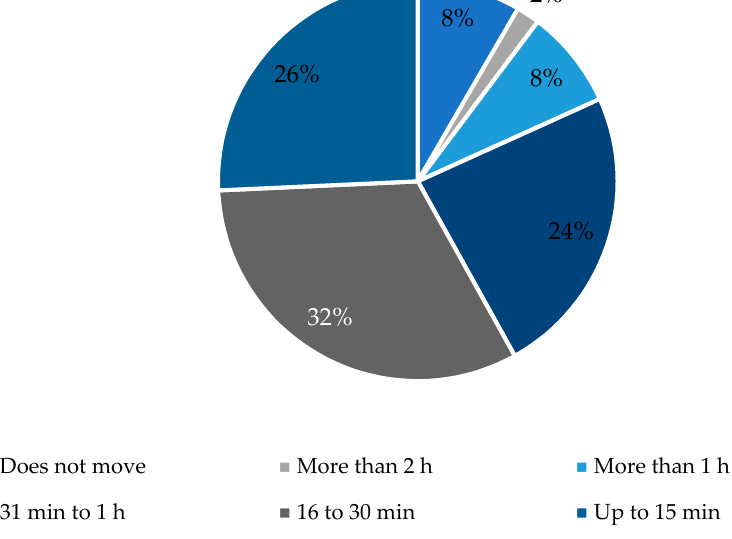
Figure 2. Distribution of commute time of the occupied population. According to the 2015 INEGI Intercensal Survey, the occupied population (32%) took between 16 and 30 min to commute to and from work, while 10% took more than an hour [37]. This figure suggests that the occupied population of metropolitan municipalities travels over long distances, moves to a different municipality facing traffic or traffic jams, or uses more than one means of transport. Figure 3 shows the main means of transport used by the occupied population.